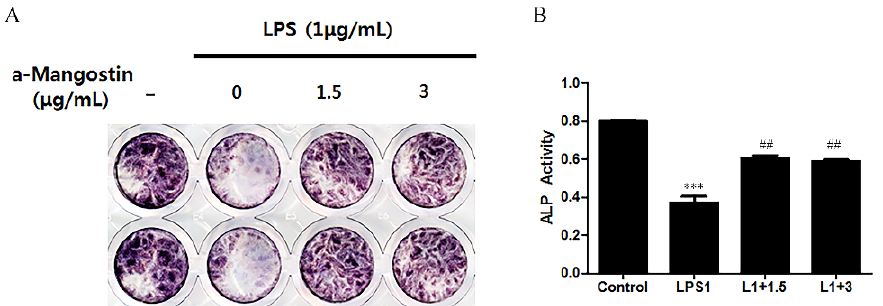
Figure 4. The effect of α -MG on the expression of ALP using ALP staining. ( A ) Image of ALP stain- ing and ( B ) Quantification of ALP staining. α -MG increased the ALP activity at concentrations of 1.5 and 3 μg/mL compared to the LPS-only treated group (*** p < 0.001 compared to the control group, ## p < 0.01 compared to the LPS-only treated group).